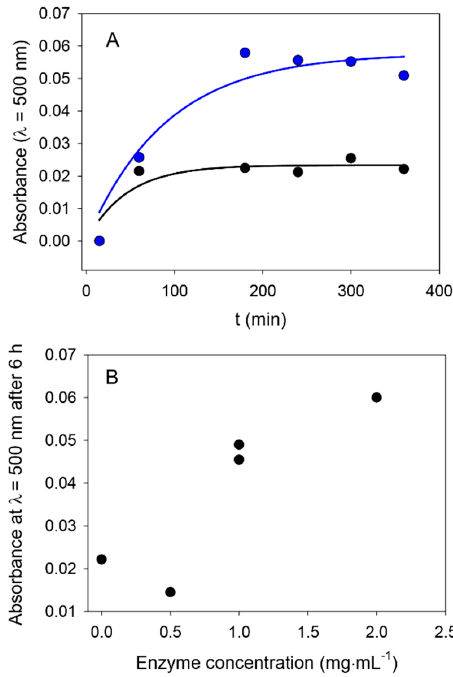
Figure 1. Investigation of the influence of ALP on dopamine oxidation. ( A ) Evolution of the absorbance at 500 nm at pH 5.0 in the presence of 20 mM NaIO 4 in the absence of enzyme ( • ) and in the presence of ALP at 1 mg · mL − 1 ( • ). The initial dopamine concentration was equal to 2 mg · mL − 1 in all cases. The solid lines correspond to an exponential decay fit to the data with rate constants of (2.3 ± 0.3) × 10 − 2 min − 1 and (5.8 ± 0.6) × 10 − 2 min − 1 in the absence and in the presence of ALP at 1 mg · mL − 1 , respectively. ( B ) Evolution of the absorbance after 6 h of dopamine oxidation (2 mg · mL − 1 at pH 5.0) as a function of the concentration of initially added ALP. Each data point corresponds to an individual curve as those described in ( A ).